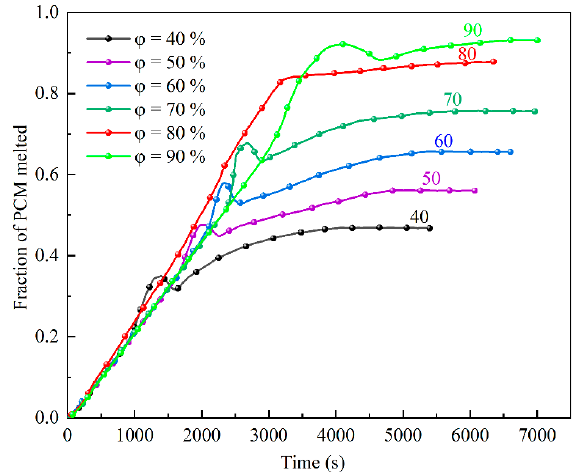
Figure 8. PCM melting time at different φ values.